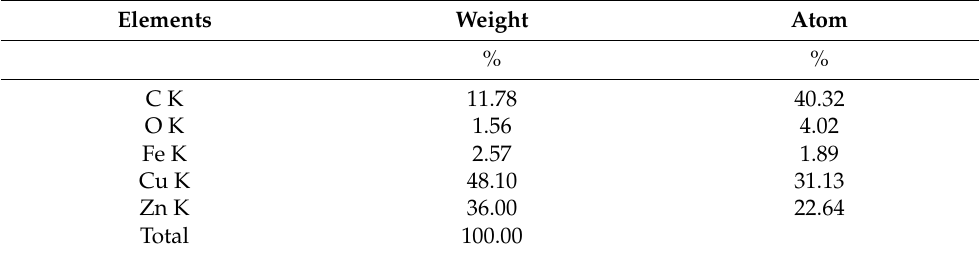
Table 2. Mass fraction and atomic percentage of the elemental content corresponding to EDS spec- trum.